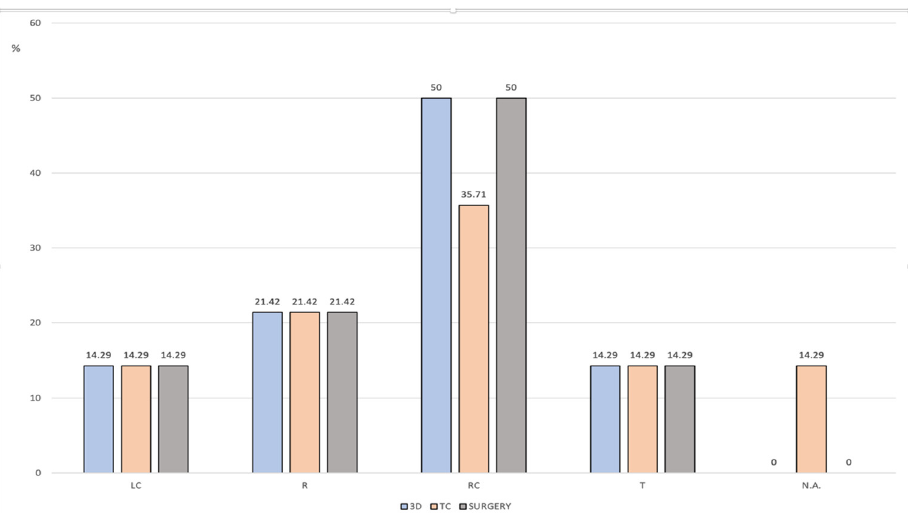
Figure 3. Frequency distribution of different types of resections performed on patients (FR: flexure resection, LH: left hemicolectomy, RH: right hemicolectomy, PME: partial mesorectal excision, TME: total mesorectal excision).